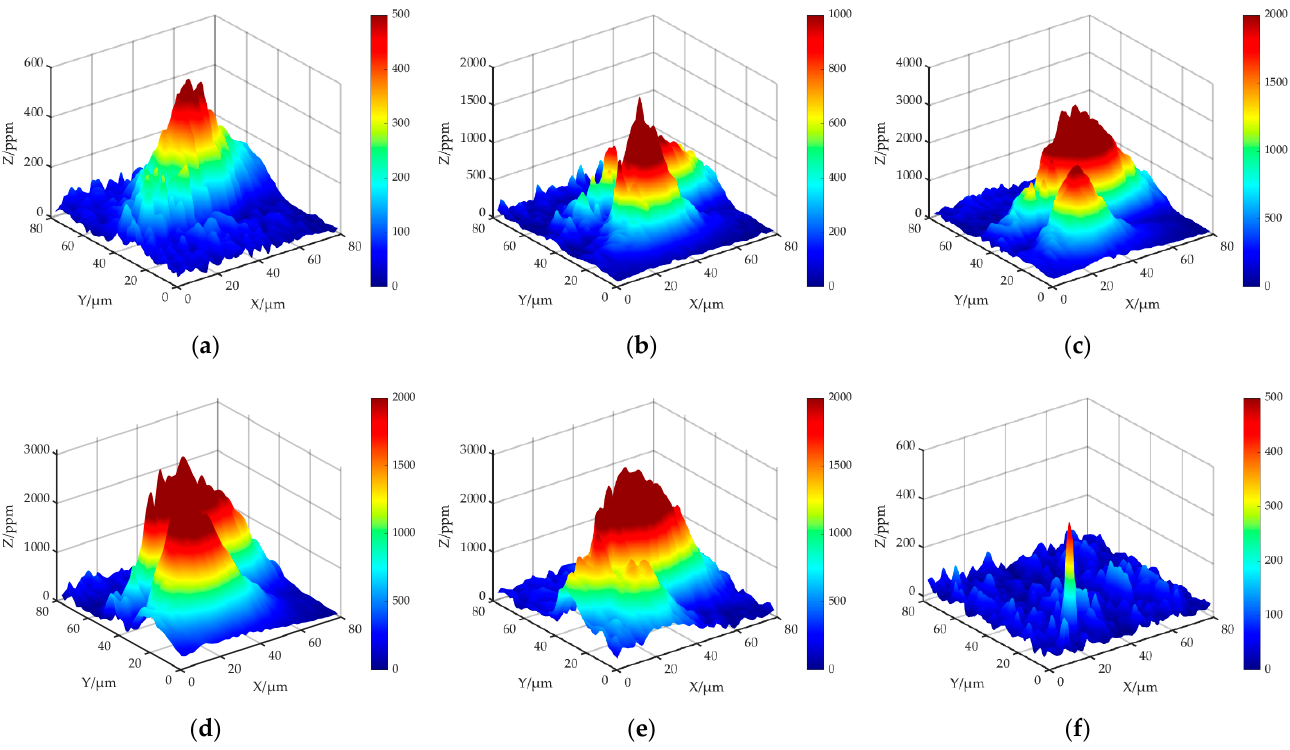
Figure 7. The images of damage photothermal absorption: ( a ) initial; ( b ) repair depth is 1 μ m; ( c ) repair depth is 2 μ m; ( d ) repair depth is 3 μ m; ( e ) repair depth is 4 μ m; ( f ) repair depth is 5 μ m.